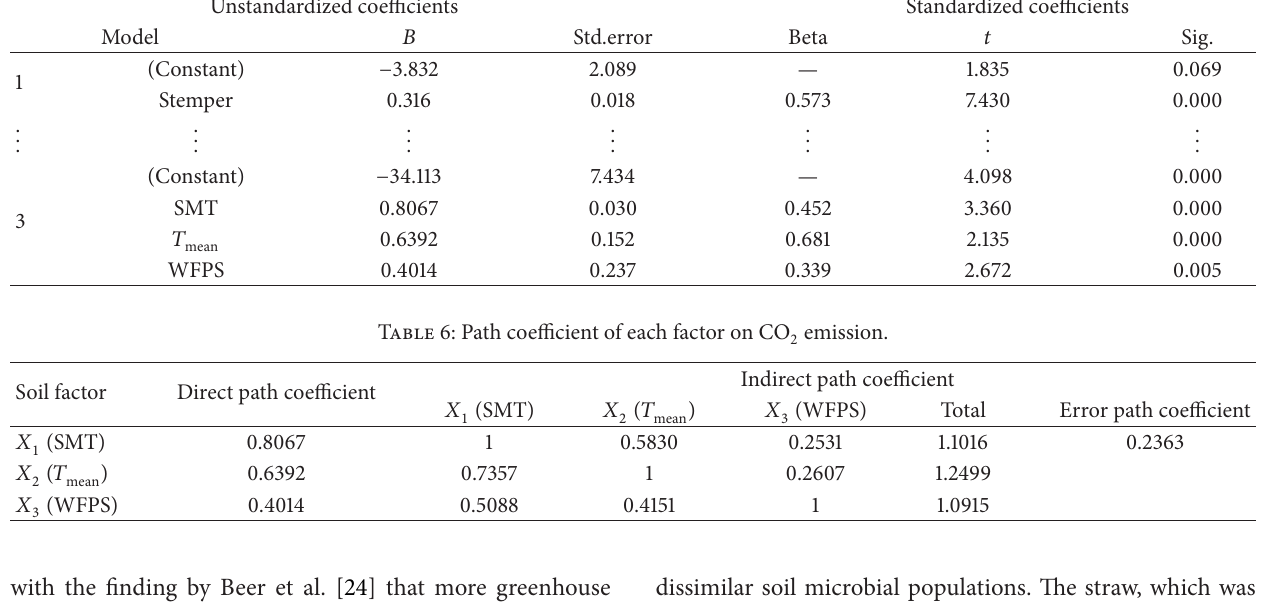
Table 5: The standard multiple regression coefficients.